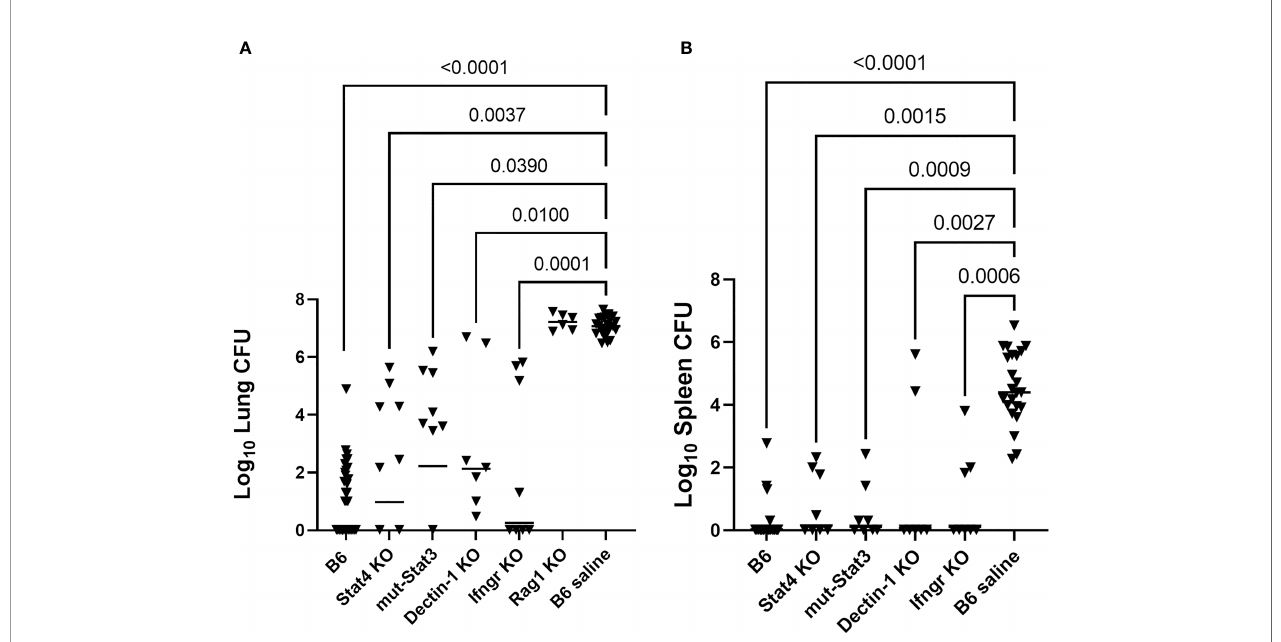
FIGURE 1 | Mice with primary immunode fi ciencies and normal C57BL/6 (B6) mice were vaccinated twice with D cps1 avirulent vaccine and challenged IN with 50- 100 arthroconidia of virulent C. posadasii Silveira. (A) Lung fungal burdens quantitated 14 days post-infection were signi fi cantly reduced in Stat4 KO, mut-Stat3, Dectin-1 KO and Ifngr KO mice compared to unvaccinated B6. Vaccinated Rag-1 KO mice, de fi cient in T- and B-cells, had no reduction in fungal burdens. (B) Dissemination was prevented in most vaccinated PID mice and statistically signi fi cantly reduced in all strains while universally present in unvaccinated B6 mice. (Statistical analysis – Kruskal-